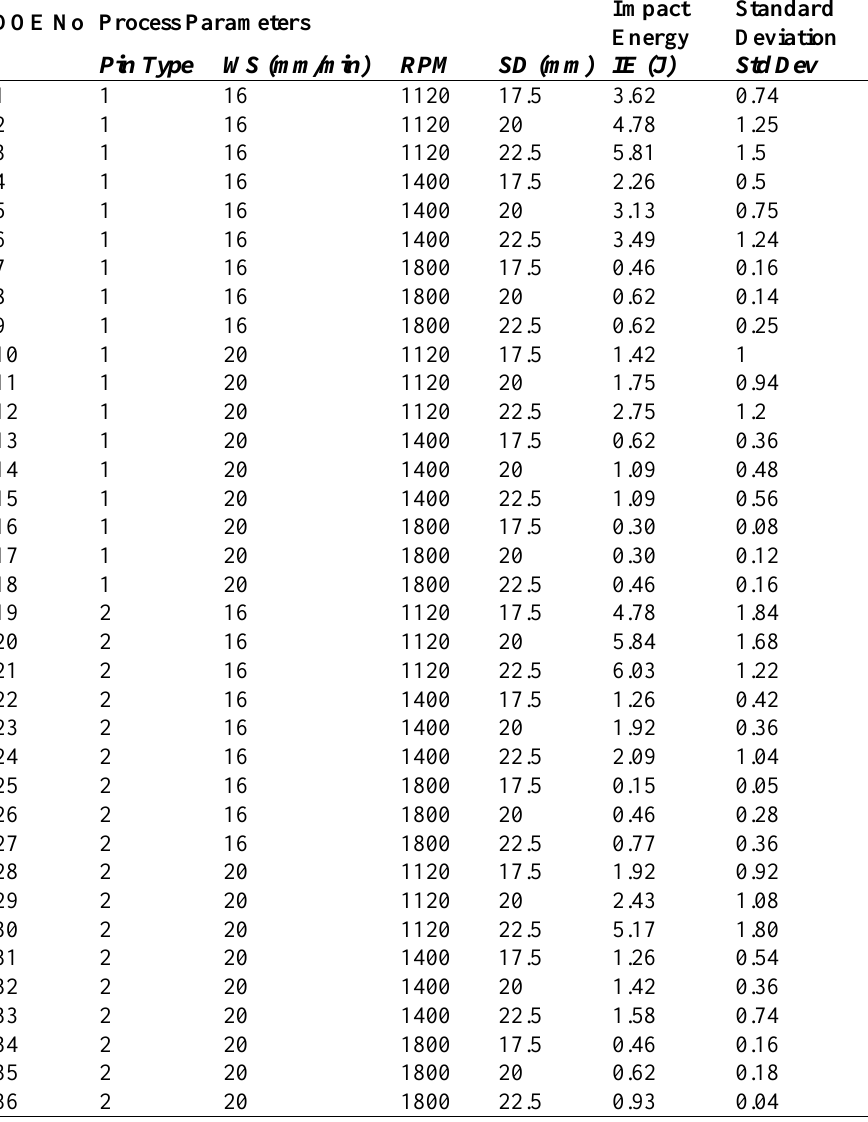
Table 4. FSW Trials using Full Factorial Method with Mixed Orthogonal Array (L 36 ). DOE No Process